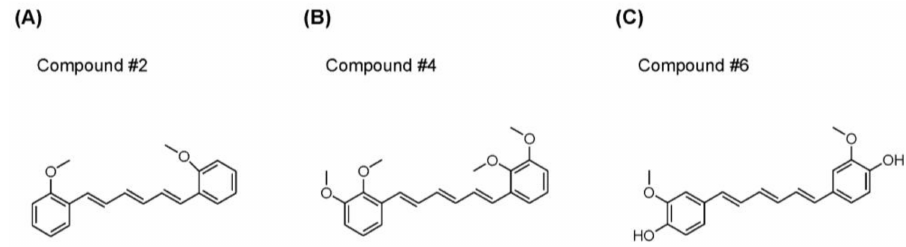
Figure 3. Chemical structure of anti-melanogenic compounds #2 ( A ), #4 ( B ), and #6 ( C